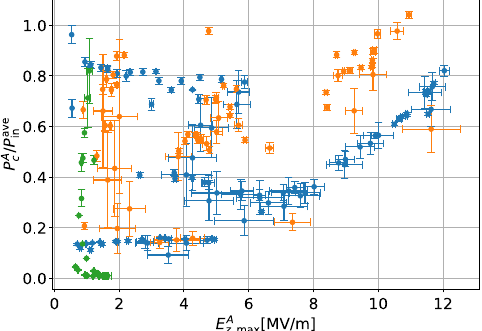
[MV/m].FIG. 8. The scatter plot of the peak accelerating gradient and the power fraction of the stored power to the input power, during the high power test for three cavities, DAA2-1-uncoated (green), DAA2-2-DLC (blue), and DAA2-3-DLC